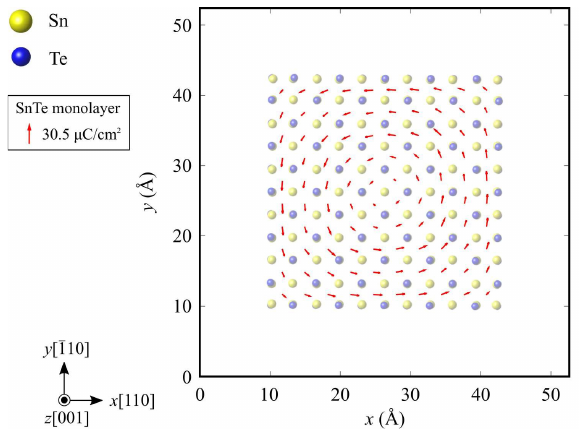
Figure 7. Vector-field representation of local polarization distribution in the 5 × 5 nanoflake. Red arrows indicate the spontaneous polarization.